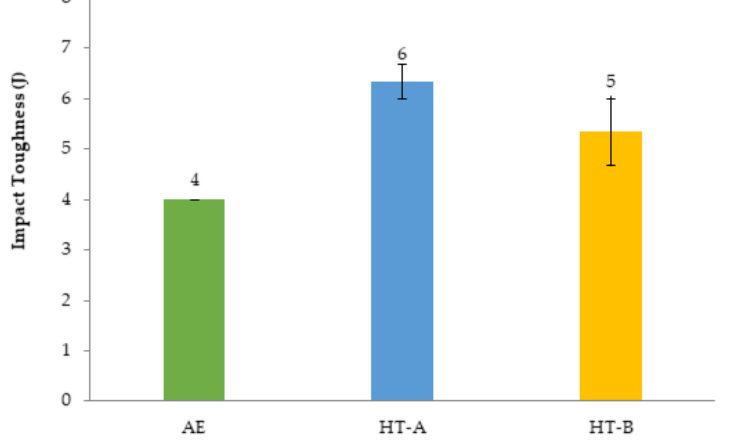
Figure 7. Histogram showing the variation in the Charpy impact toughness values of Ti-6Al-4V alloy in the as-extruded condition and after two different heat treatments.